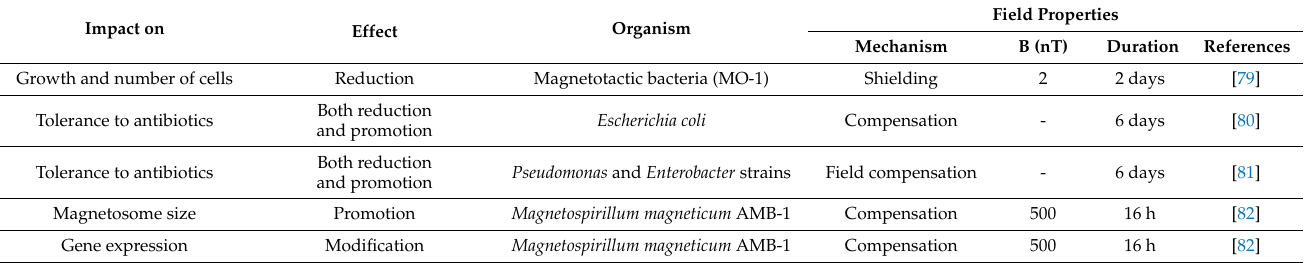
Table 4. Impact of hypomagnetic field on procaryotic microorganisms (B—magnetic flux density in Tesla